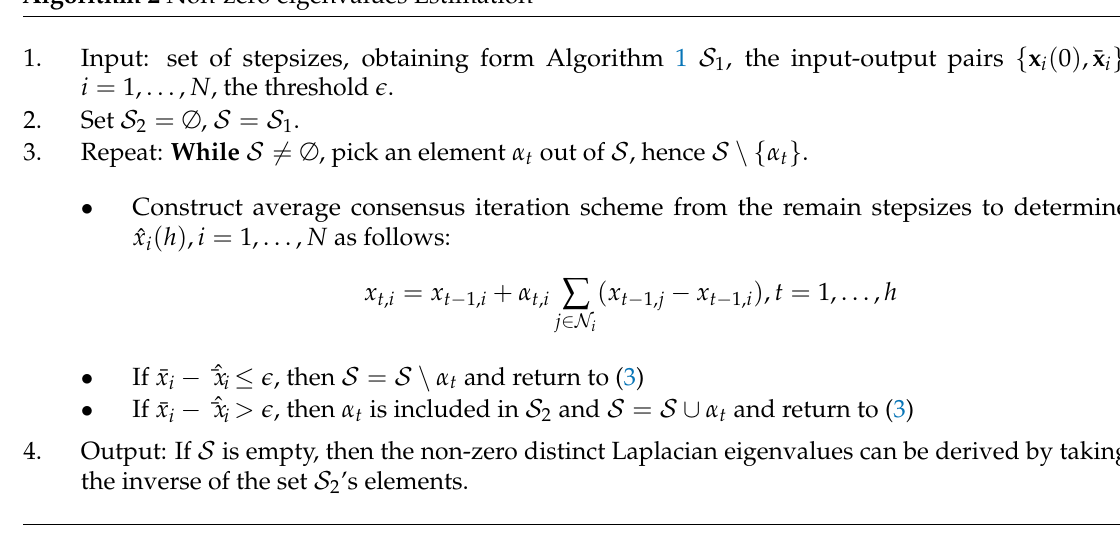
Algorithm 2 Non-zero eigenvalues